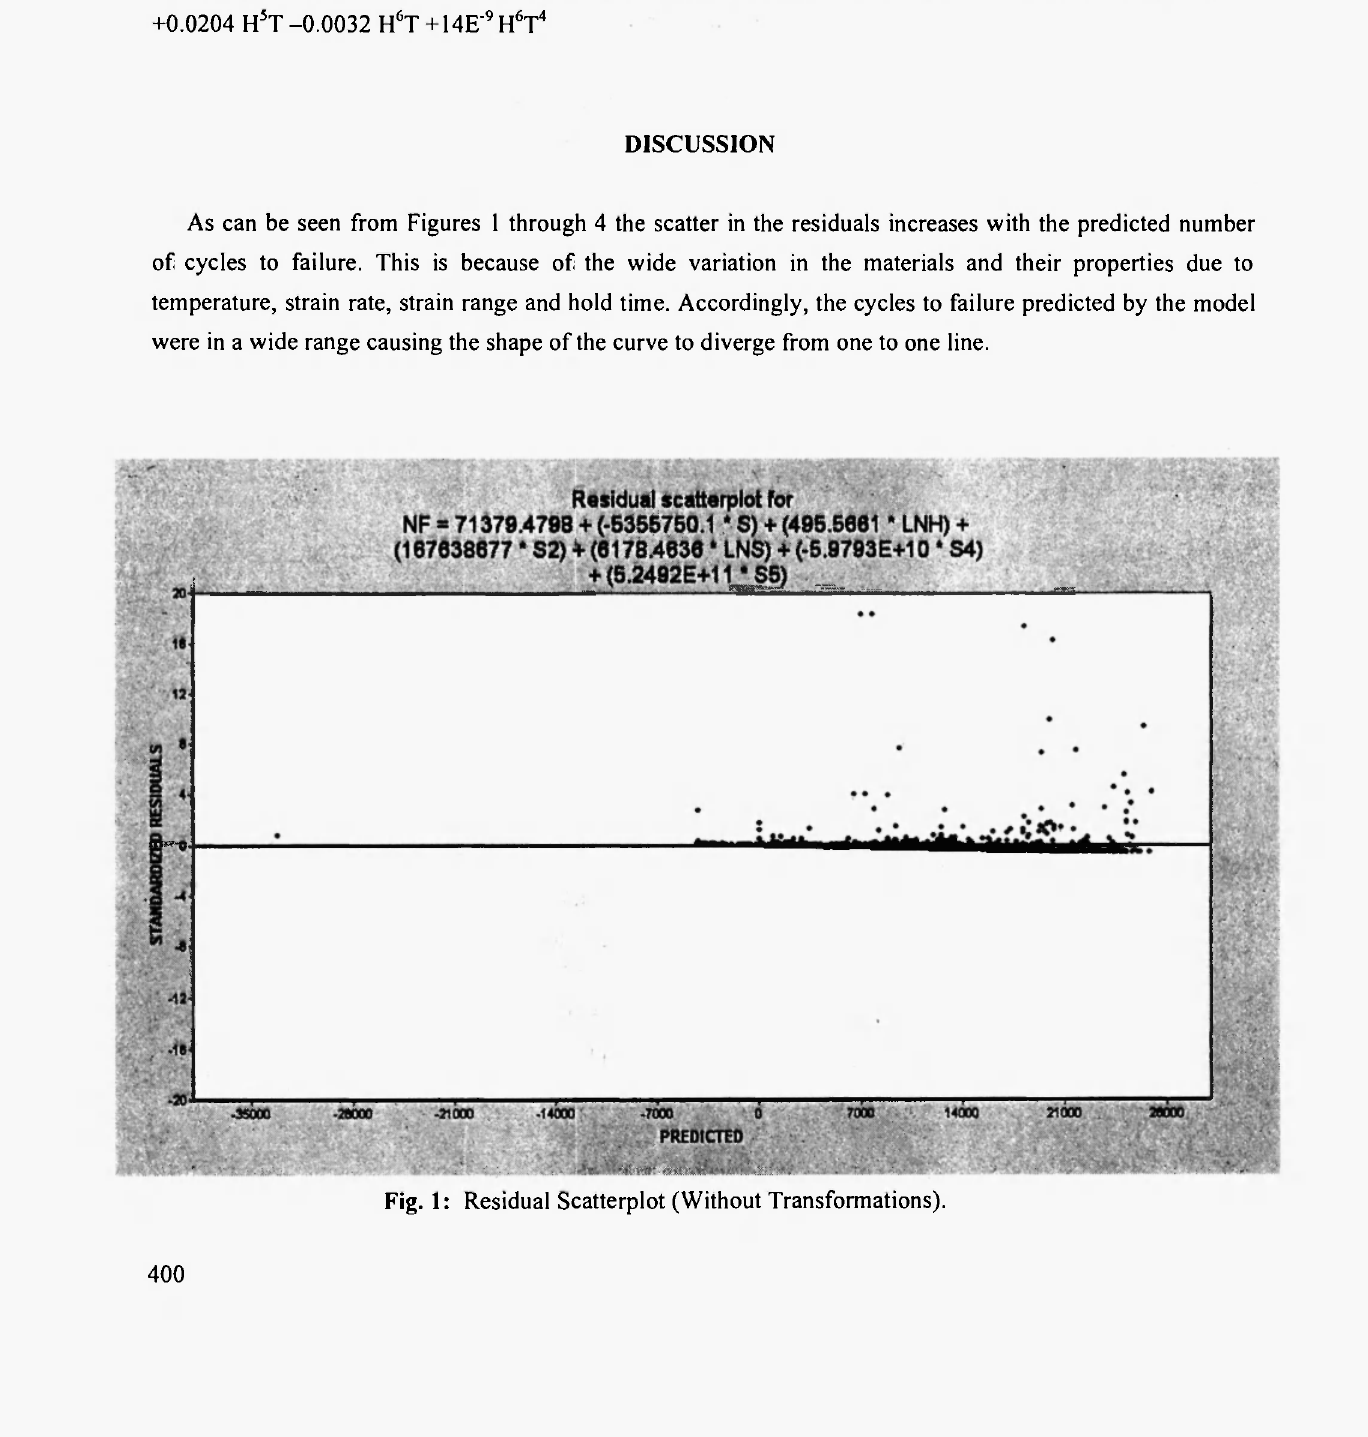
Fig. 1: Residual Scatterplot (Without